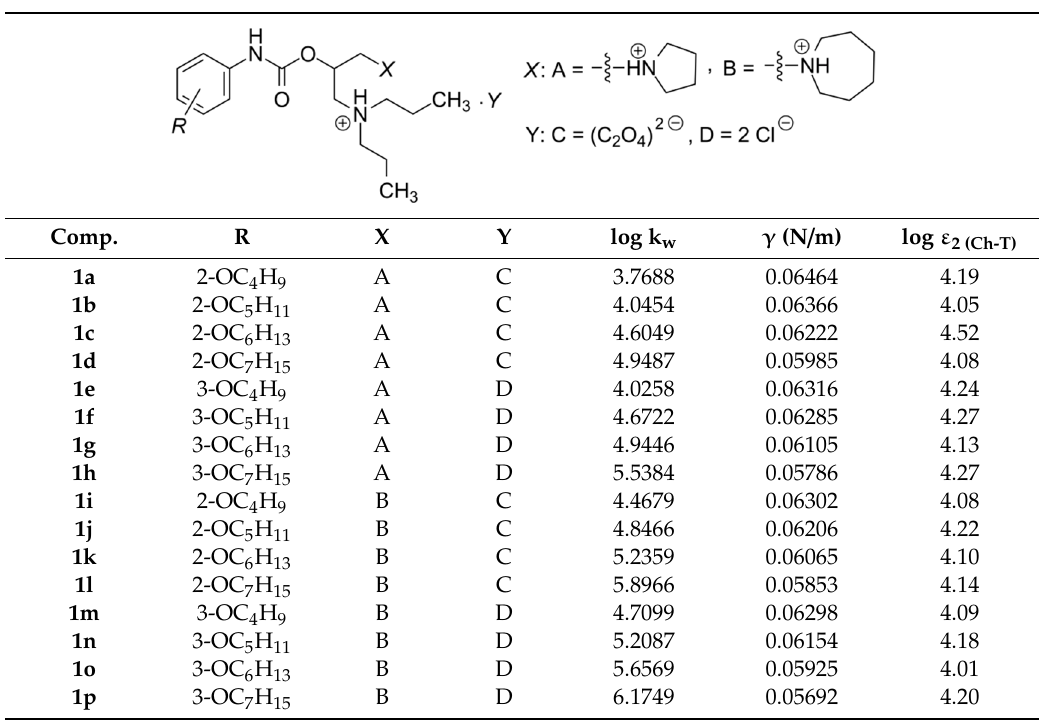
Table 1. Chemical structure of investigated compounds 1a – 1p determined lipophilicity (log k w ) estimated by isocratic reversed-phase (RP)-HPLC, surface tension γ (relative surface activity (N/m)), and logarithms of molar absorption coefficients (log ε 2 (Ch-T) ) of methanolic solutions ( c = 8.0 × 10 − 5 M) of individual compounds (taken from Malik et al. [54]).